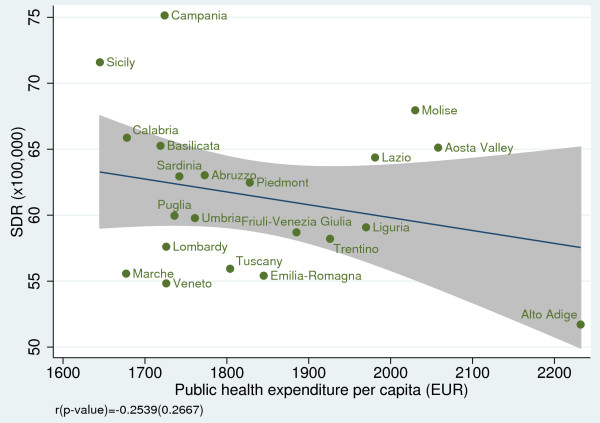
Amenable mortality vs. public health expenditure per capita for the year 2008. Data source: Rapporto Osservasalute 2011 [16].